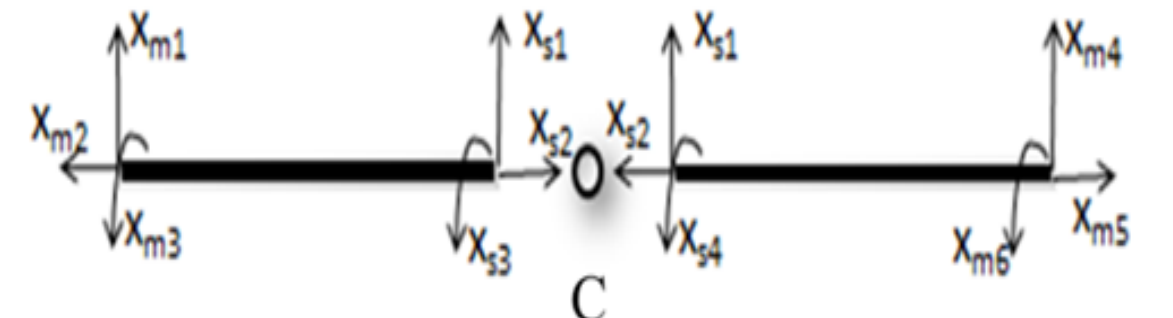
Figure 2. Diagram of horizontal beam connector